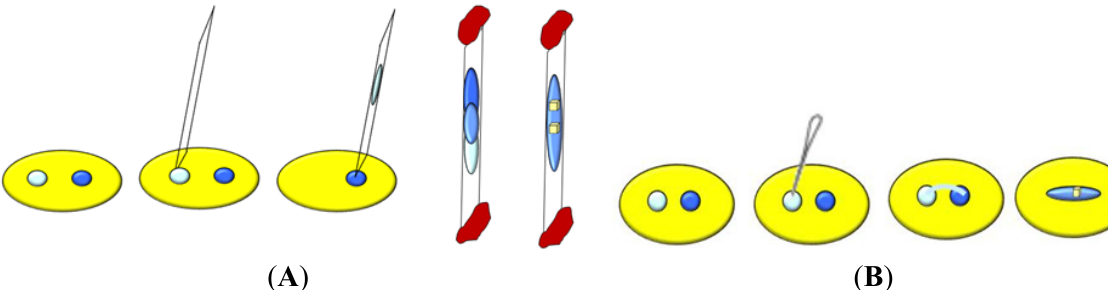
Figure 7. Free interface diffusion method. ( A ) Protein and precipitant solutions are